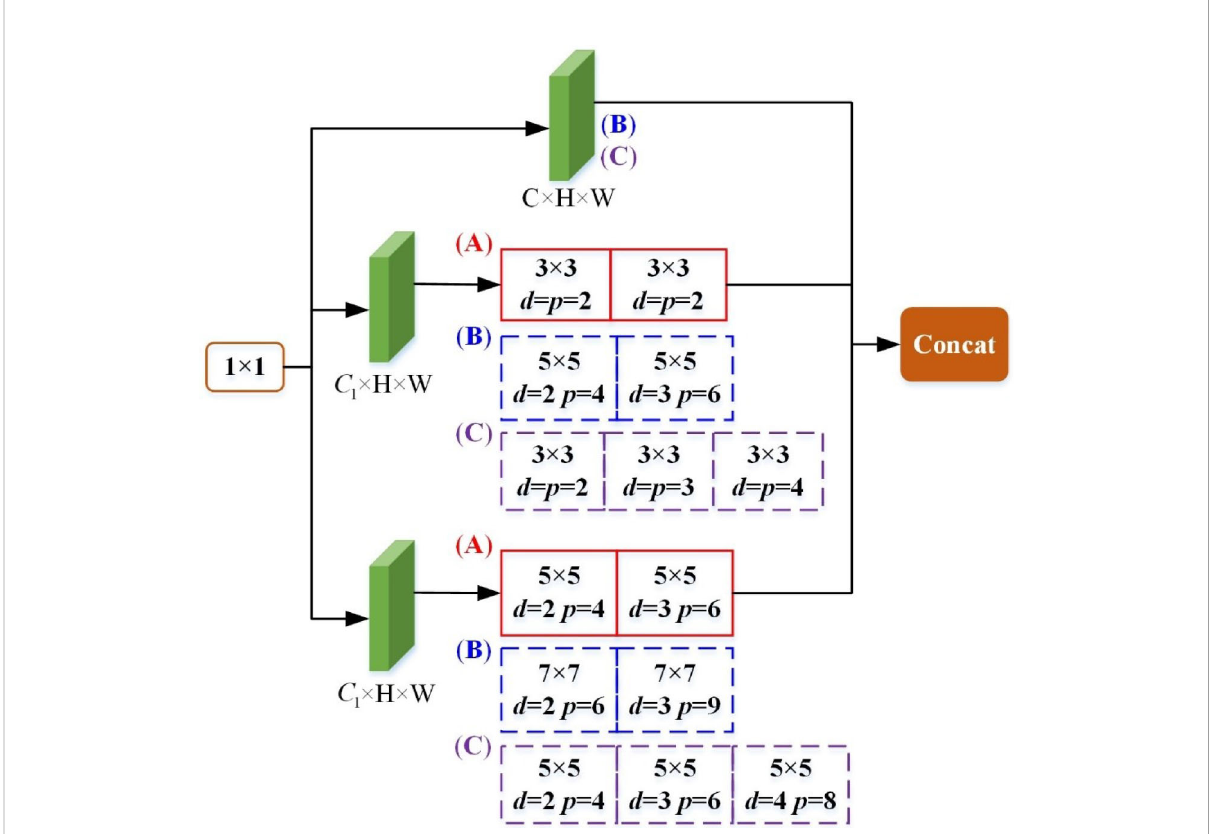
FIGURE 7 Schematic of three joint dilation convolution structures, where C is the number of channels, H is the height of the feature map, W is the width of the feature map, d refers to dilation rate, and p refers to padding. (A) is the structure of JDC1, with the parameters of JDC1 in the red solid box, (B) is the structure of JDC2, with the parameters of JDC2 in the blue dashed box, and (C) is the structure of JDC3, with the parameters of JDC3 in the purple dashed box.